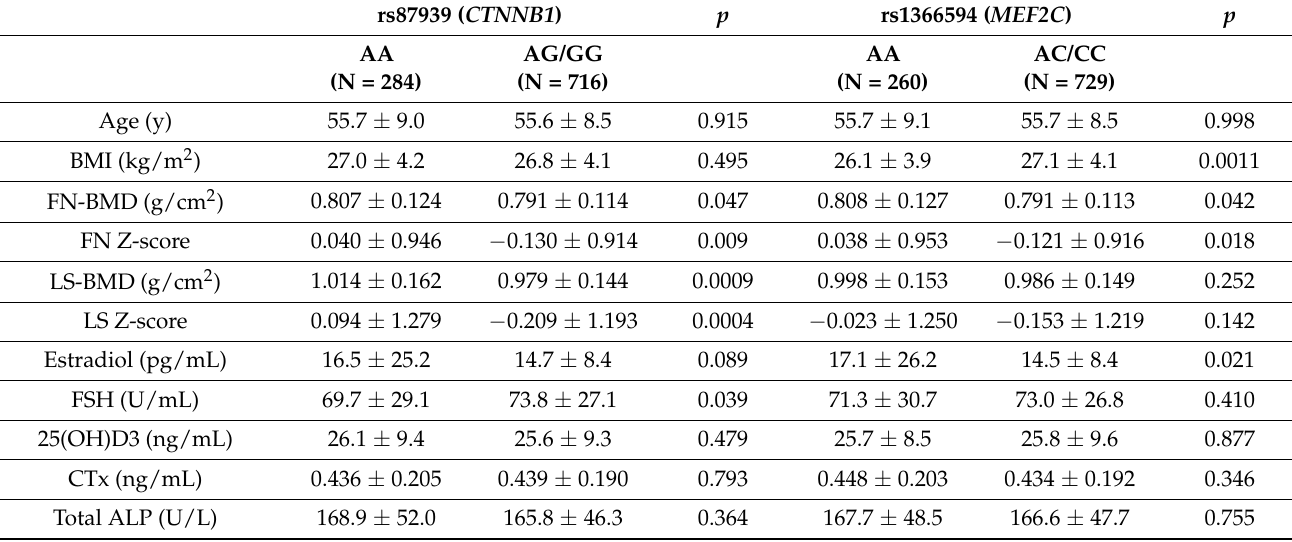
Table 5. Biochemical and bone characteristics of subjects according to rs87939 ( CTNNB1 ) and rs1366594 ( MEF2C )